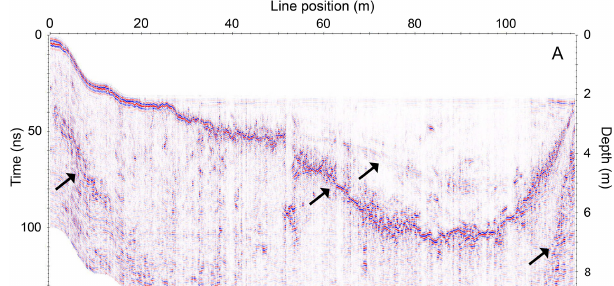
Figure 10. Processed 400MHz ground-penetrating radar data for the transverse line (west to east) from the debris-covered rock glacier across the icefalls fed by Doran Glacier and ending at the east-lateral ice-cored ridge. Image after migration and topographic correction using a constant velocity of 0.16mns − 1 . The prominent internal reflection event starts as a near-surface reflection event at the beginning of the profile. Interpreted as an interface between sur- face debris and internal ice, the debris layer dips below the exposed ice at the ∼ 20m line position before emerging at the ice-cored ridge (right side of profile). Arrows point to reflection events inter- preted to be internal debris layers, likely recording periods of retreat of the source